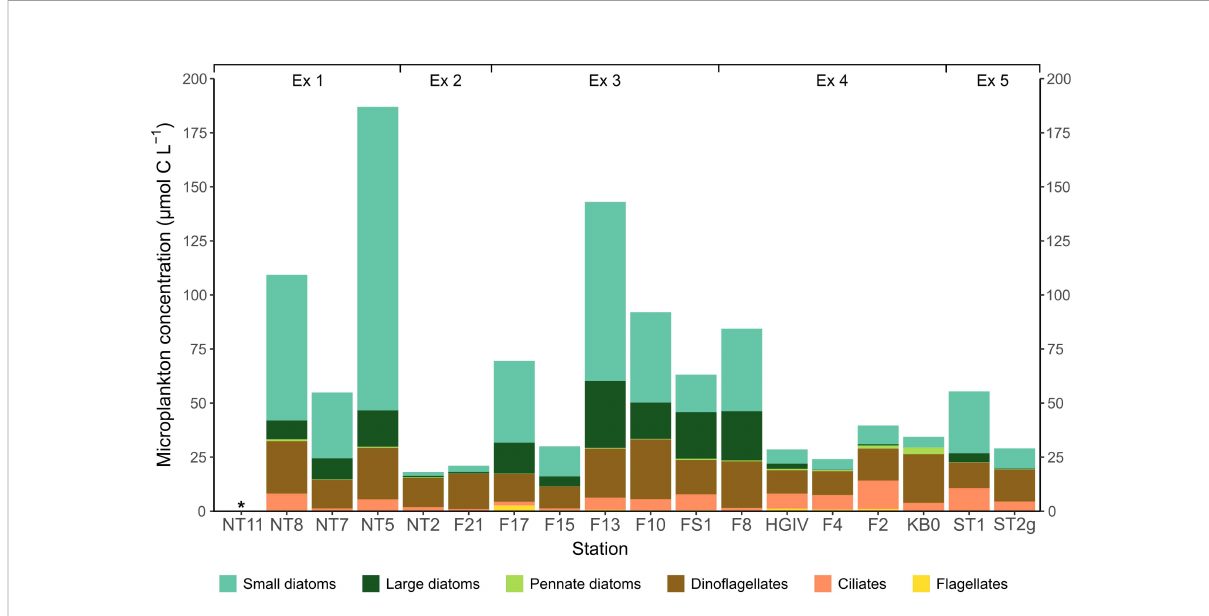
FIGURE 2 The microplankton food environment for Calanus fi nmarchicus across the Fram Strait, calculated from inverted microscopy of water sampled at the chlorophyll maximum at each station. *indicates where the parameter was not